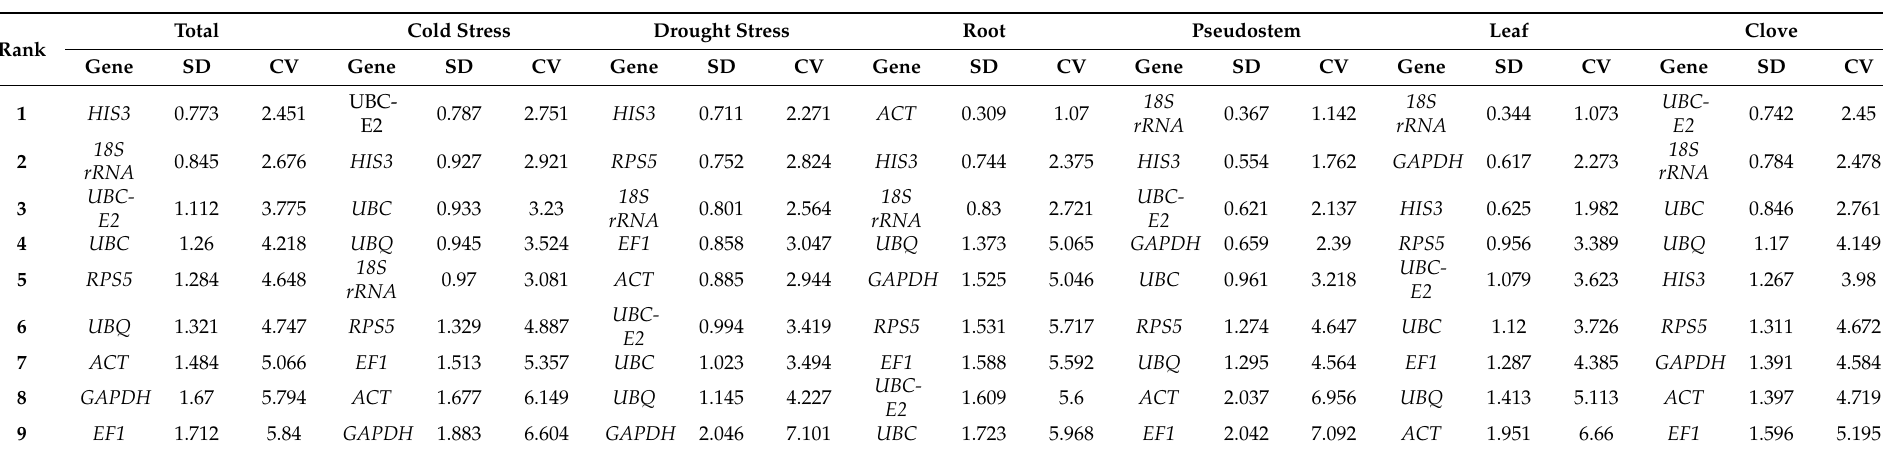
Table 3. Stable values of nine candidate reference genes in different treatments and tissues in